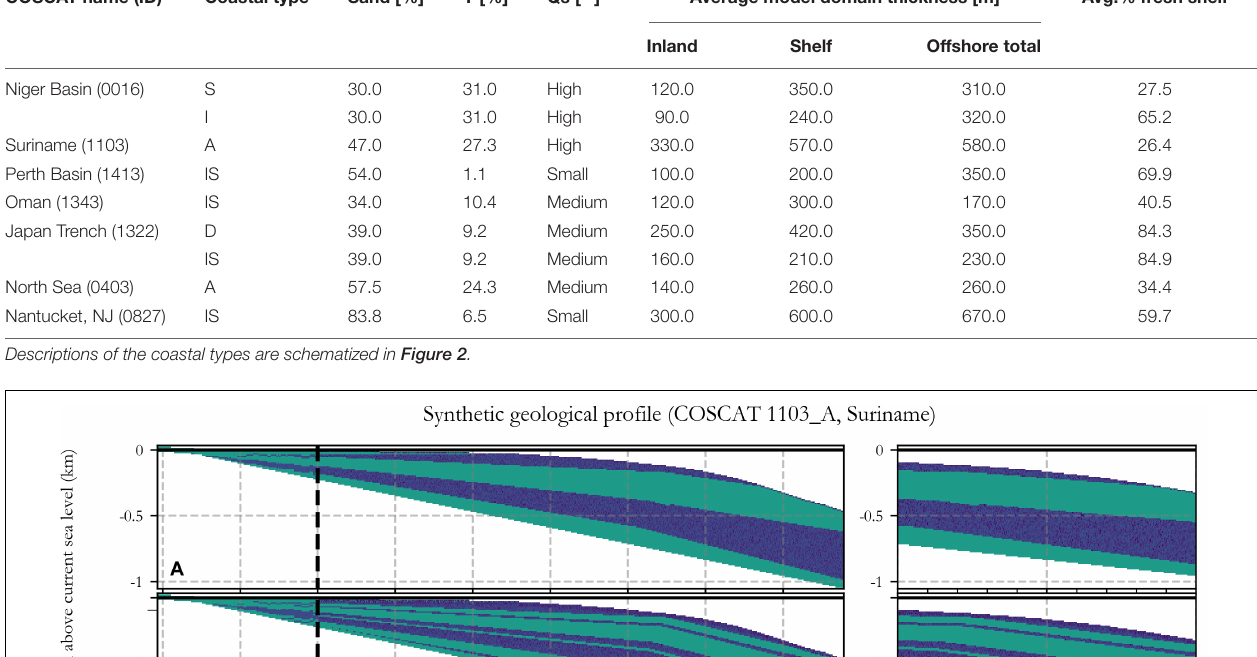
TABLE 2 | Global geological heterogeneity parameter estimation for the seven selected sample COSCAT regions (see Figure 5 ). COSCAT name (ID) Coastal type